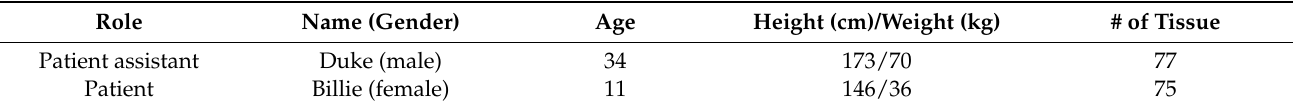
Table 1. Numerical human body